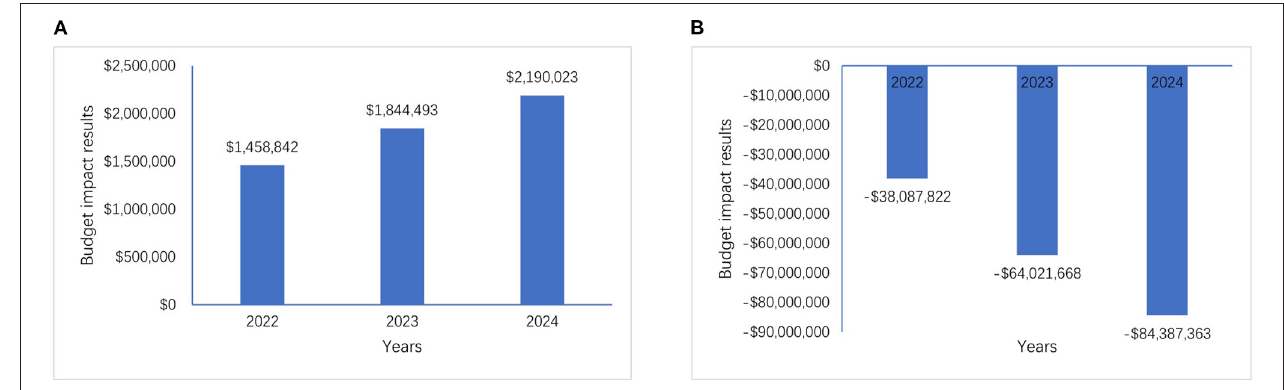
FIGURE 3 | Budget impact results of two cost-scope scenarios, (A) is the budget impact results without considering subsequent treatment costs and (B) is the budget impact results with considering subsequent treatment